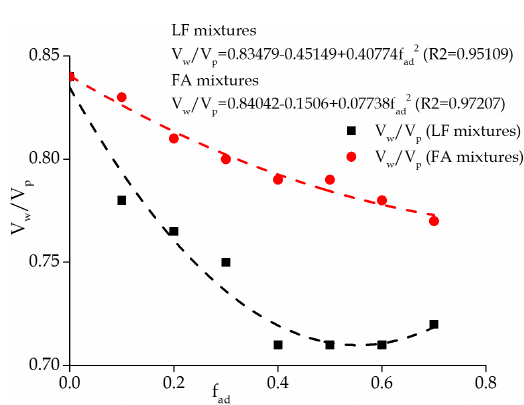
Figure 4. Correlation between V between the total quantity of water and fine materials) and the f (percentage replacement of cement by